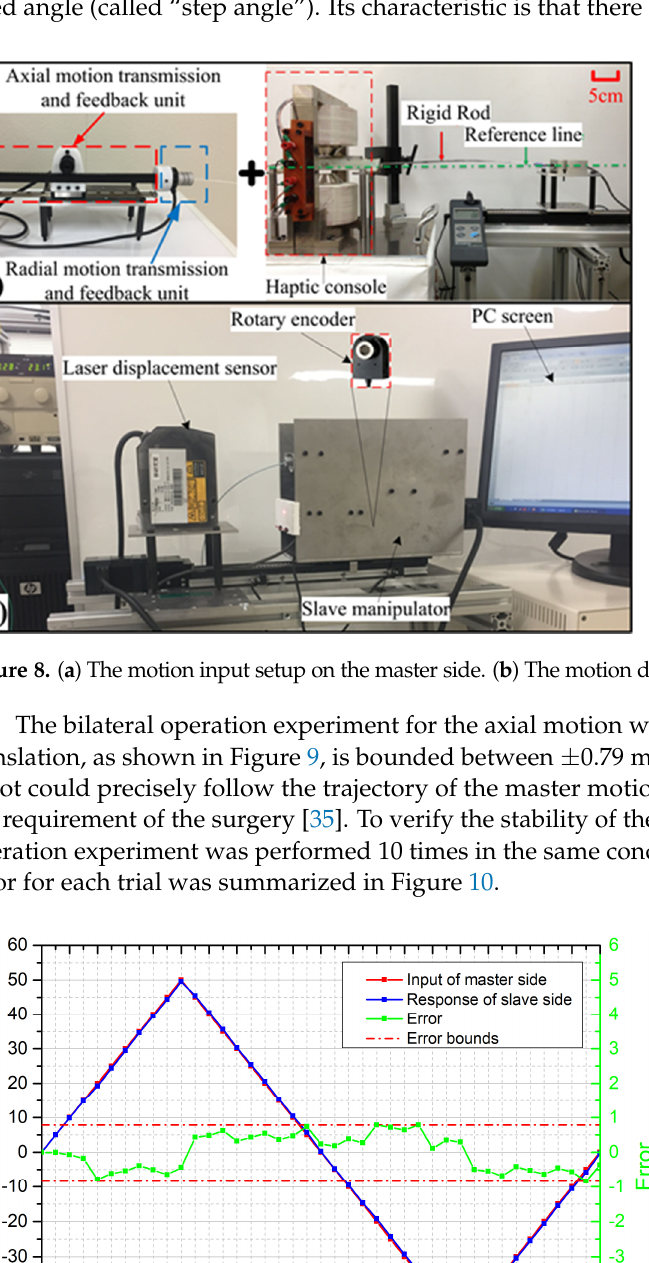
Figure 10. Mean error of ten times experiments for the axial motion. The bilateral operation experiment to evaluate the radial motion was conducted. The performance of radial motion transmission and the error is shown in Figure 11. The results show that the rotation error is bounded between ±1.7 degrees. After 10 times tests, the mean absolute error for each time was summarized in Figure 12. From the results, the standard deviations relative to their mean values have a significant discreteness. How- ever, it can be acceptable because the absolute error within 2 degrees in this system could not affect the direction adjustment of the catheter/guidewire tip.